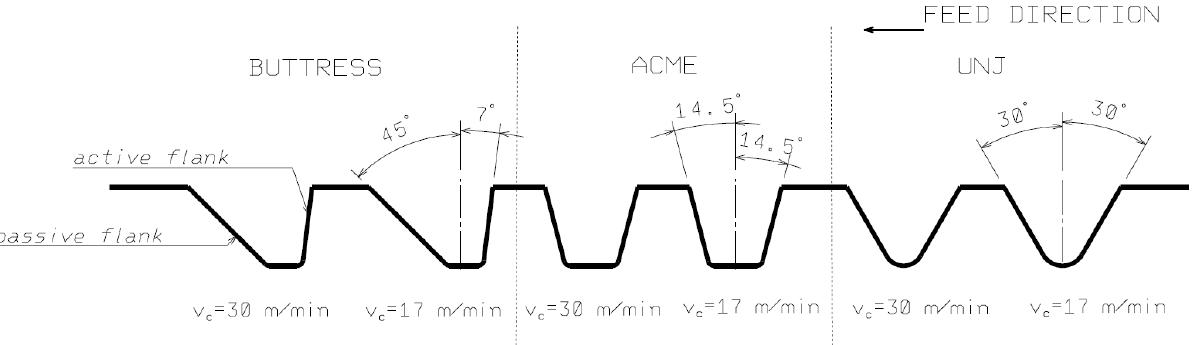
Figure 1. Schematic representation of the research object: trapezoidal asymmetrical thread — BUTTRESS; trapezoidal symmetrical thread — ACME; triangular thread — UNJ.